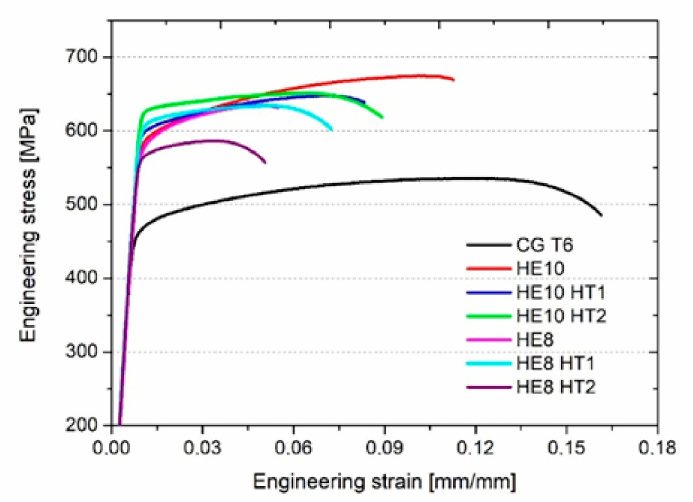
Figure 12. Representative engineering stress–strain curves for the reference CG T6 sample and samples after hydrostatic extrusion with subsequent natural aging (HE10 and HE8) and artificial aging (HT1 and